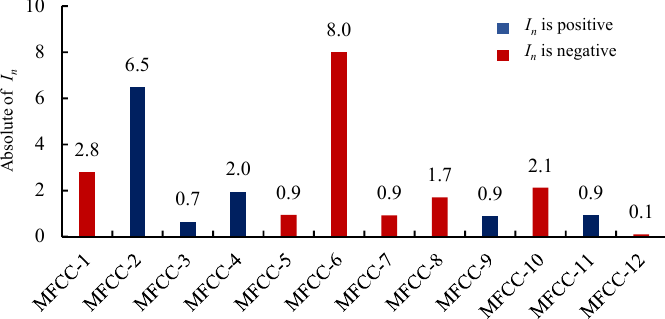
Figure 11. Absolute importance of sample features of AIEFPC.